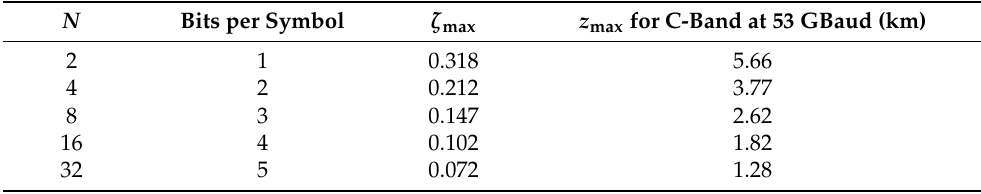
Table 1. Evaluation of Equation (22) for different Q-values.